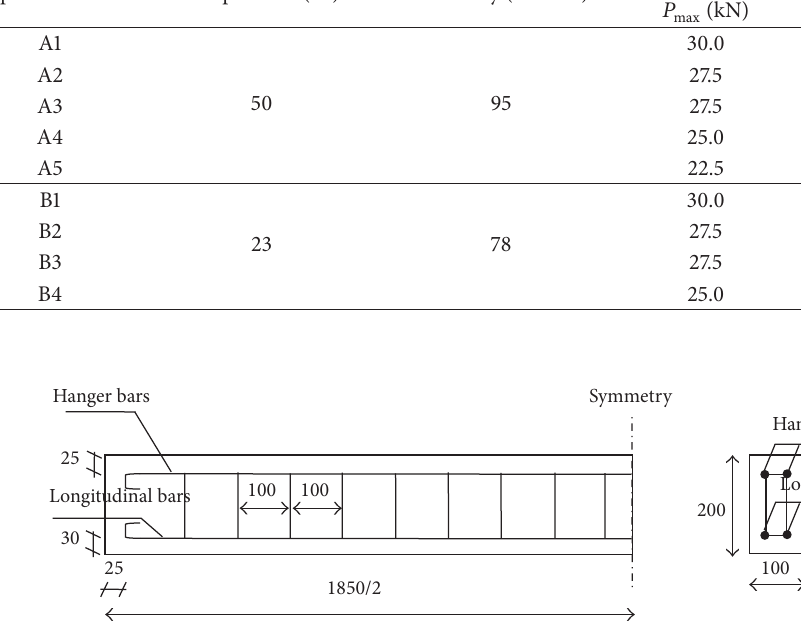
Figure 9: Size of steel bars used in RC beam.